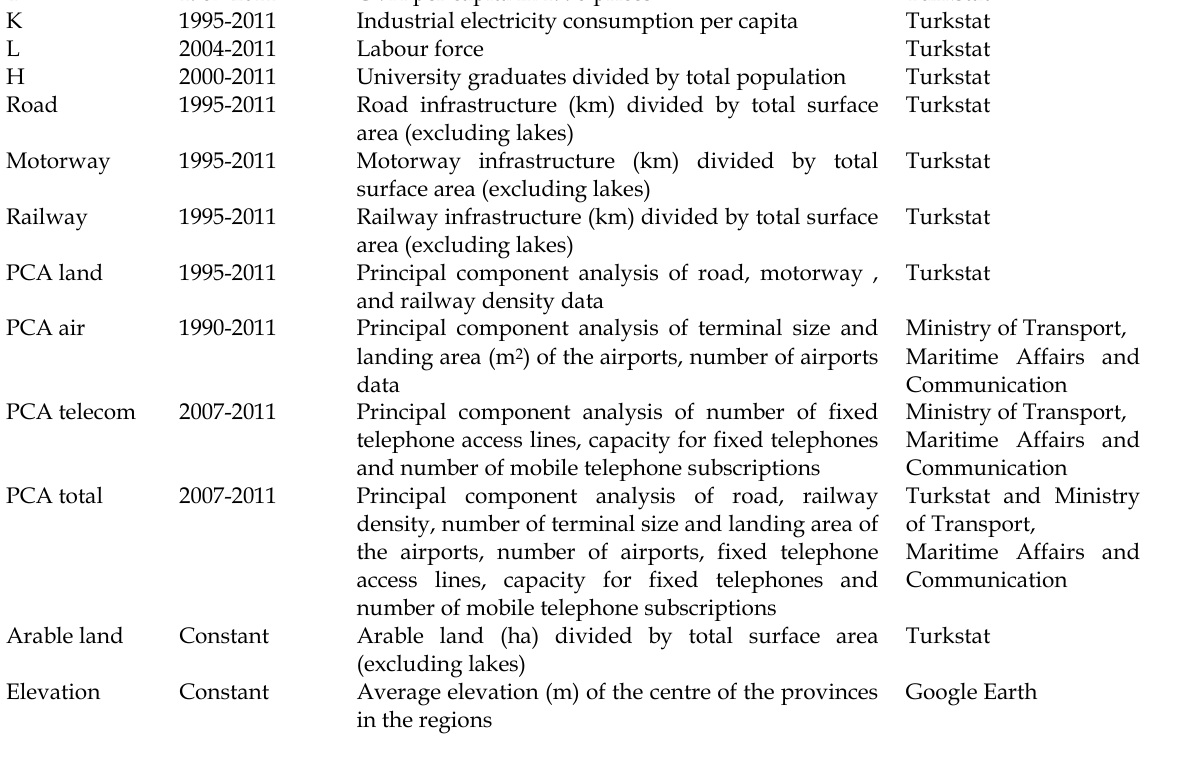
Table 3. Definitions of